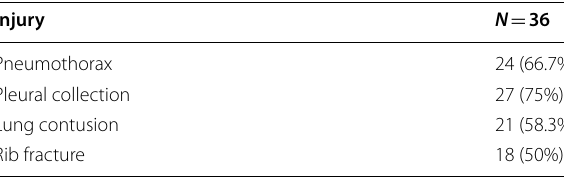
Data were expressed in form of frequency (percentage)